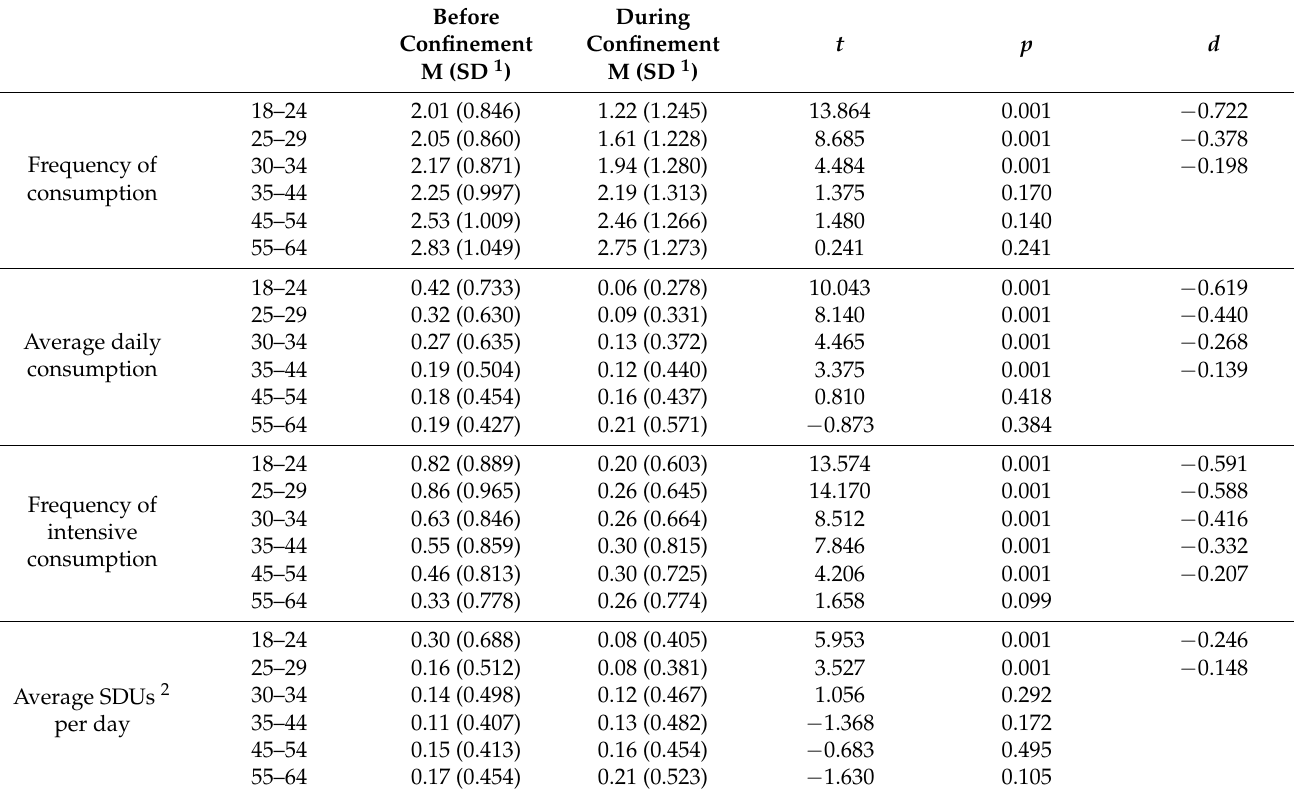
Table 2. Alcohol consumption patterns before and during confinement as a function of age ( n = 2282).